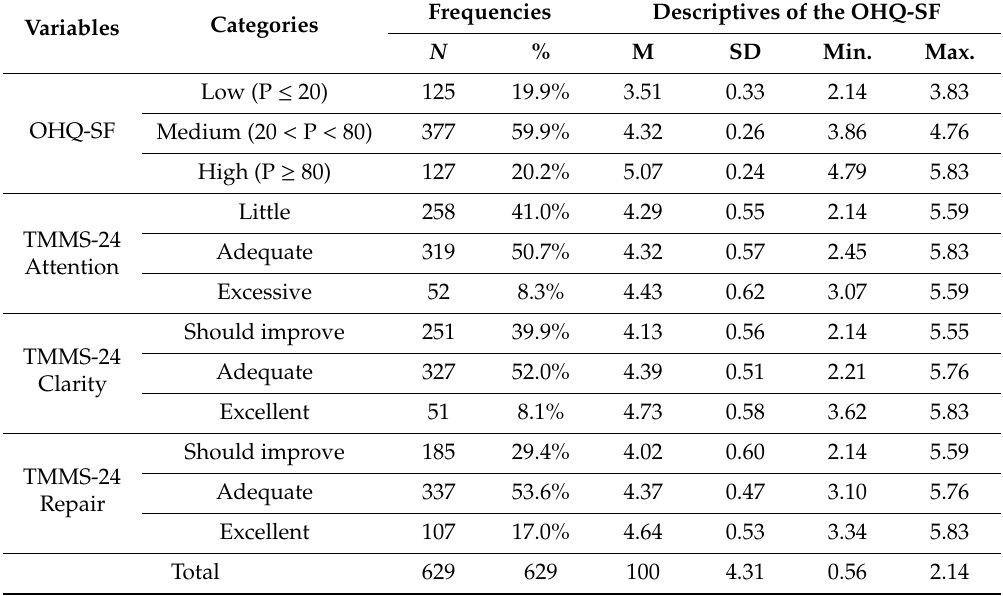
Table 1. Categorization and frequencies of the study variables and descriptive statistics of the OHQ-SF questionnaire.